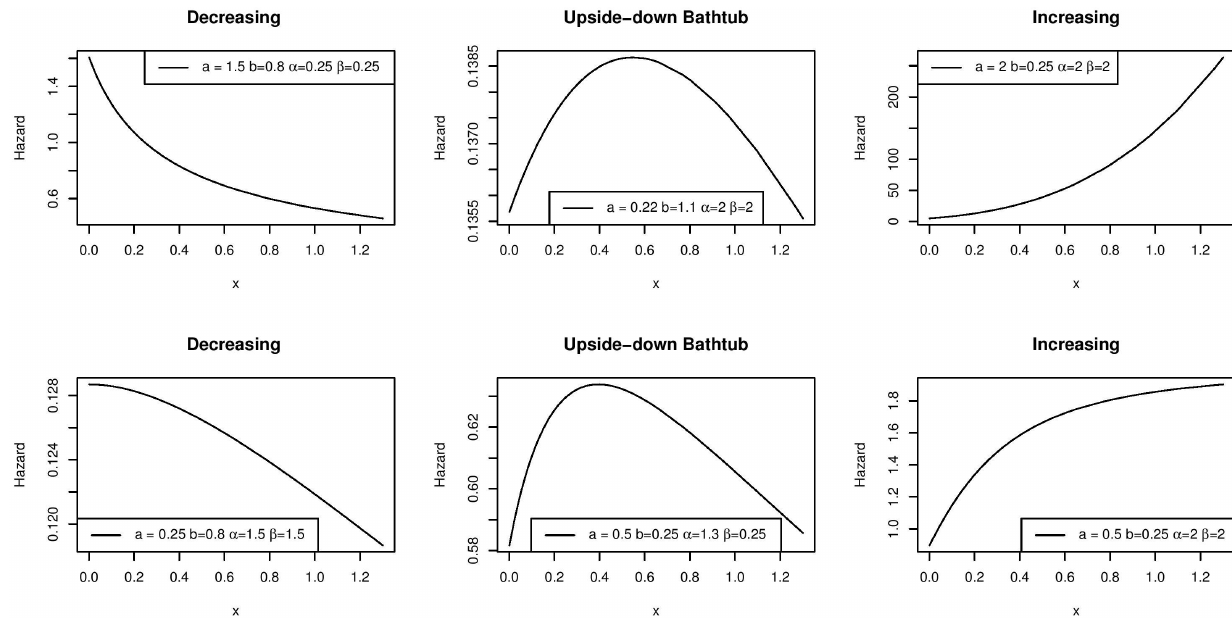
Figure 2. Curves of the hrf of the NHLx distribution for various parameter